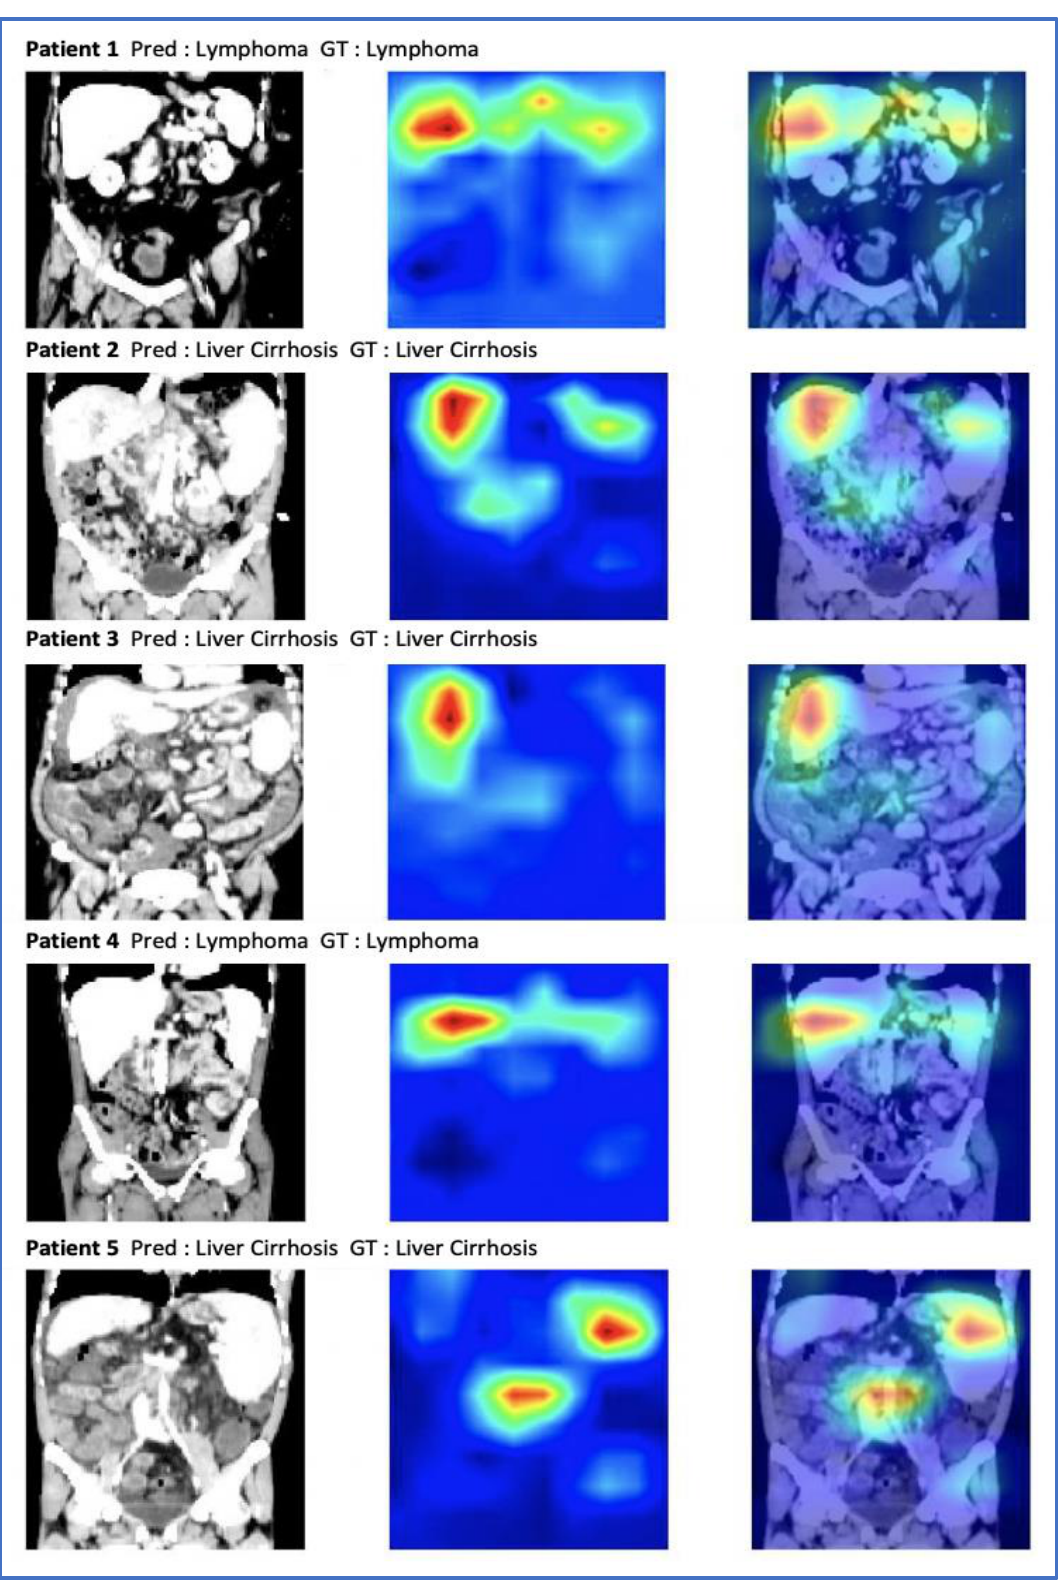
Figure 6. A selection of abdominal CT images with the ground truth (GT), the prediction (Pred), and the occlusion sensitivity maps superimposed on the input images. Red pixels correspond to a lower classification performance when occluded.